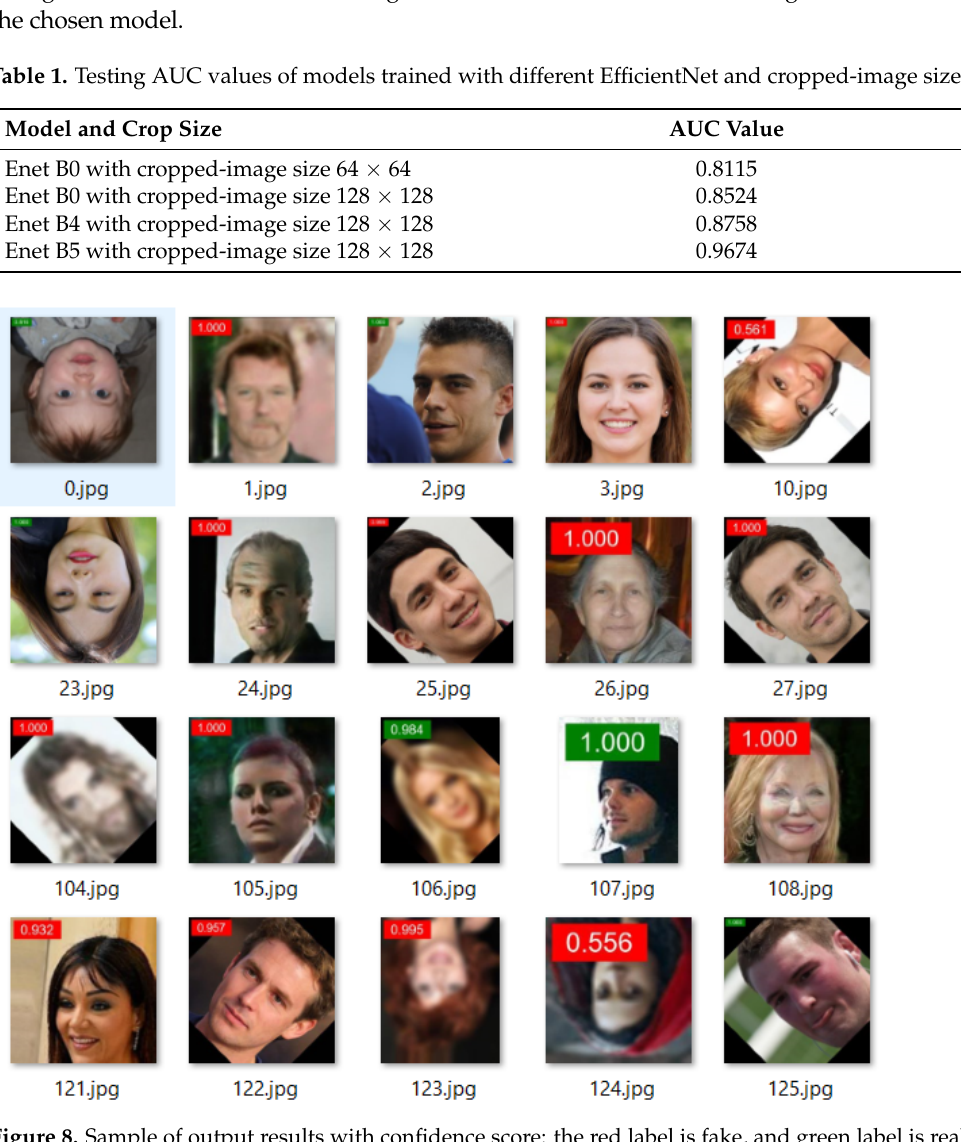
Figure 8. Sample of output results with confidence score: the red label is fake, and green label is